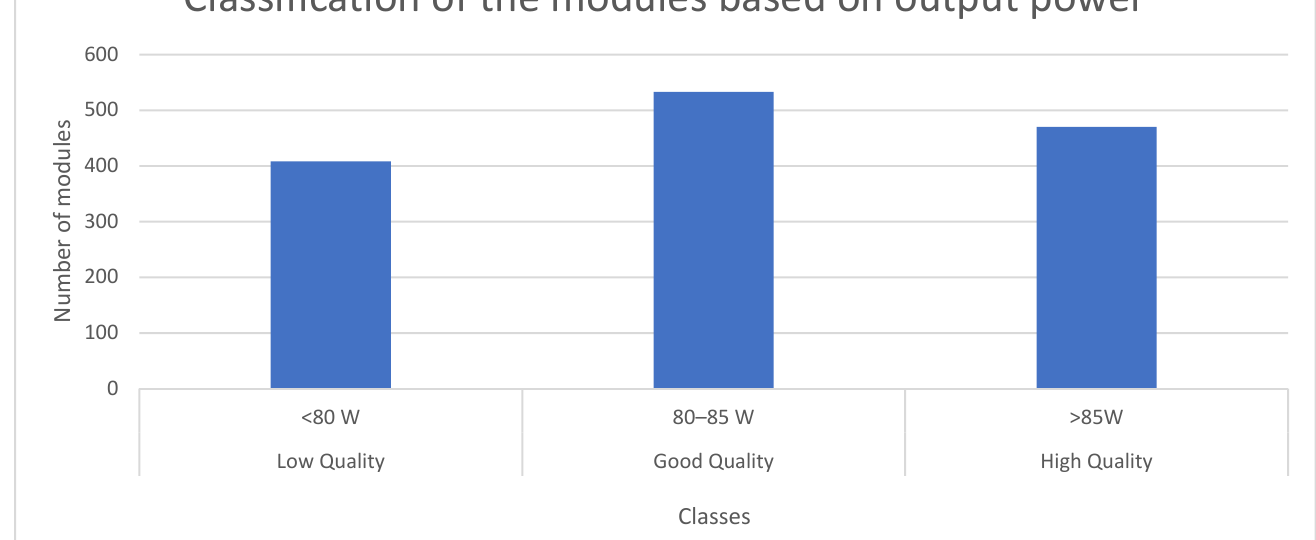
Figure 5. New classification of the modules based on their output power.